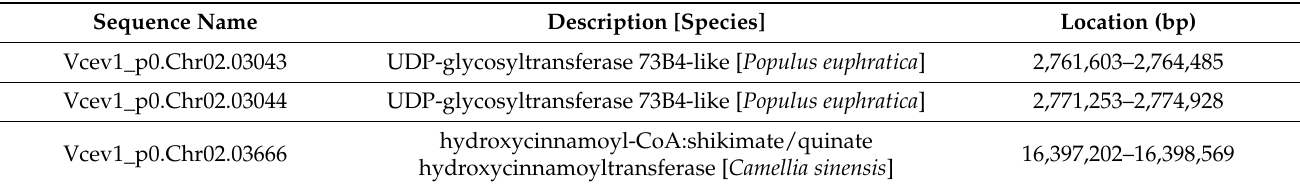
Table 6. Candidate genes on Vc02. Nine candidates with annotations related to the CGA biosynthesis pathway were located within the significant region on Vc02. The gene name, annotation, the species from which the annotation was derived, and physical location are shown.